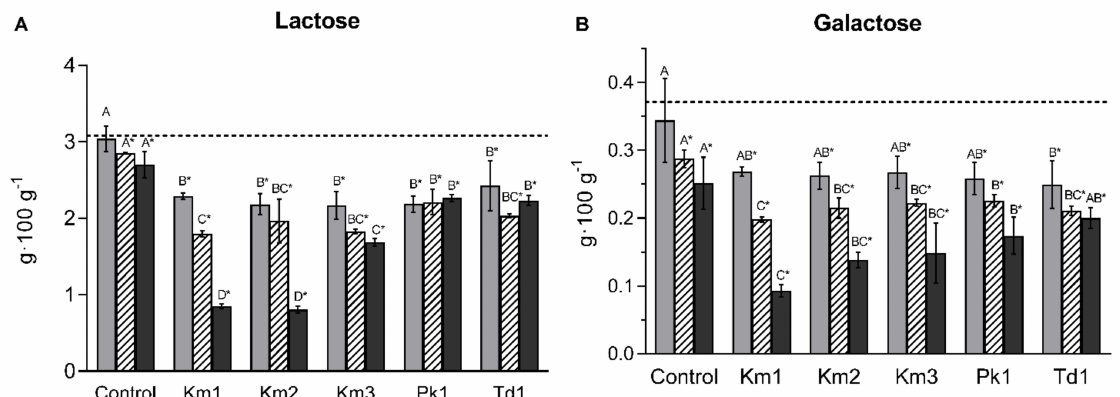
Figure 5. Concentration of lactose ( A ) and galactose ( B ) in skyr after 7 days (grey columns), 14 days (white columns) and 21 days (black columns) incubation of yeasts K. marxianus (strains Km1, Km2 and Km3), P. kudriavzevii Pk1 and T. delbrueckii Td1 at 8 ◦ C, and in controls (skyr without yeasts). The dashed lines show initial concentration of lactose and galactose in skyr (mean values at Day 0). Mean values and SD (bars) from triplicate experiments are presented. Different subscripts denote statistical differences ( p < 0.05) between the yeast strains within the same period of incubation determined by the one-way ANOVA (Tukey’s post-hoc analysis). Asterisks indicate values significantly different from Day 0 (Student’s t -test, p <